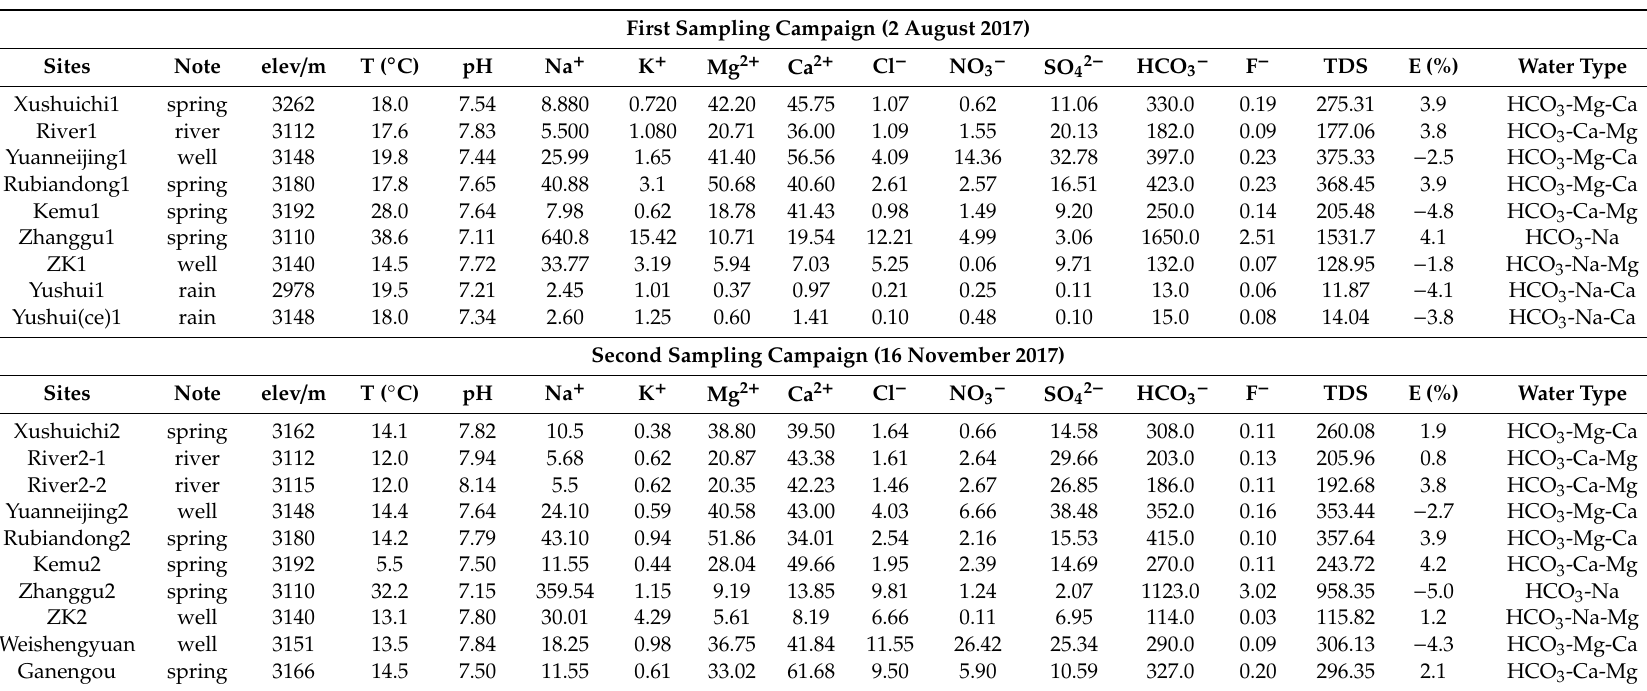
Table 1. Results of chemical analyses of the water samples collected during two sampling campaigns (note: 1 represents the first sampling campaign, and 2 represents the second sampling campaign). Unit: mg /